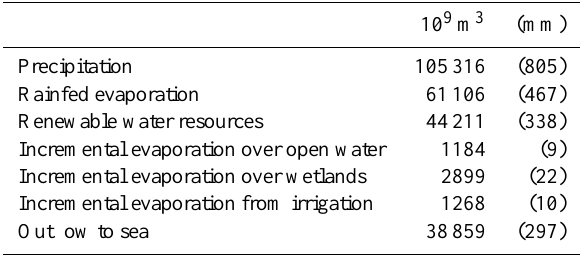
Table 6. Global terrestrial water